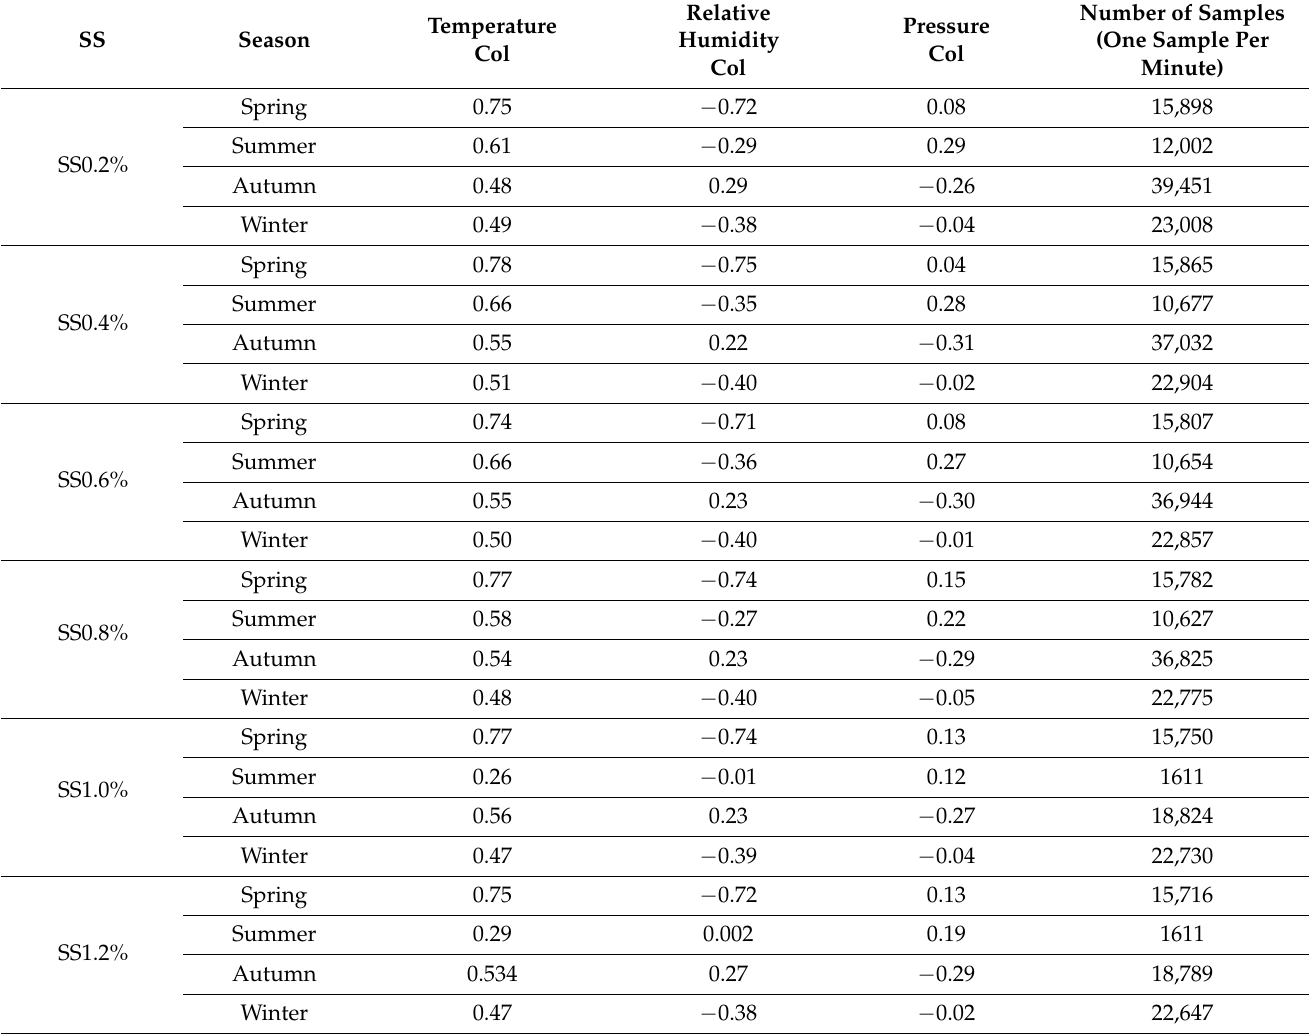
Table 2. Correlation between CCN concentration and meteorological